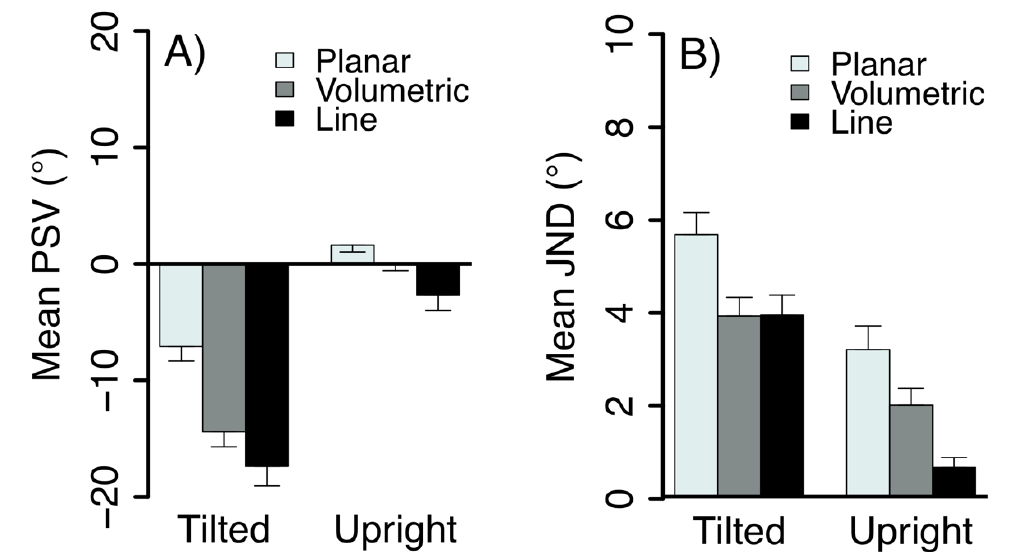
Figure 5. The mean ( A ) Point of subjective verticality (PSV) and ( B ) Just noticeable difference (JND) averaged across observers as a function of head tilt and stimulus type ( ± 1 standard error of the mean (SEM)). A lower JND represents greater certainty or precision in judging the stimulus tilt.